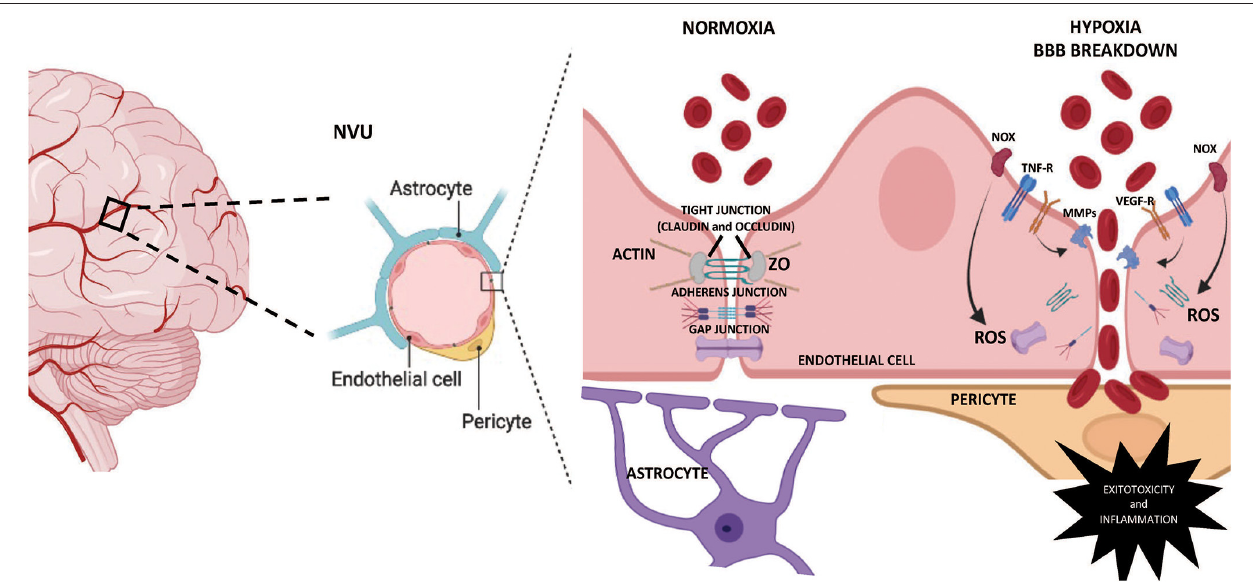
FIGURE 1 | Schematic representation of the BBB permeability mechanisms. The NVU is the main anatomical unit of the blood-brain barrier (BBB), sheltering the brain from systemic influences by limiting transcellular and paracellular transport. The Brain endothelial cells contain no fenestrae and undergo very low rates of transcytosis. Tight junctions, adherens junctions, and gap junctions formed between adjacent endothelial cells underlie the physical barrier that impedes paracellular diffusion of ions, macromolecules, and other solutes. Fetal chronic hypoxia may determine increased permeability in the BBB through pro-inflammatory and oxidative mechanisms, inducing degradation and damage in the membrane’s integral proteins, leading to BBB breakdown. MMPs, metalloproteinases; NOx, NADPH oxidase; NVU, neurovascular unit; ROS, reactive oxygen species; TNF-R, Tumor necrosis factor receptor; VEGF-R, vascular endothelial growth factor receptor; ZO, zonula